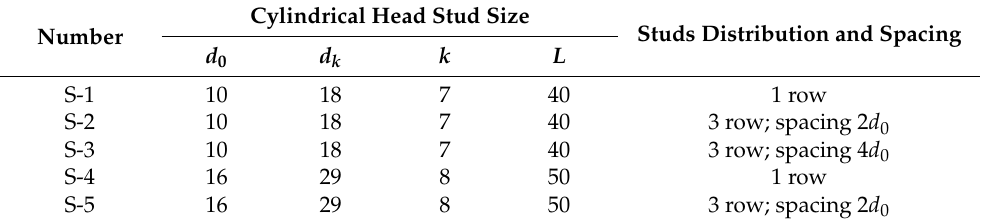
Table 1. S series related parameters of each